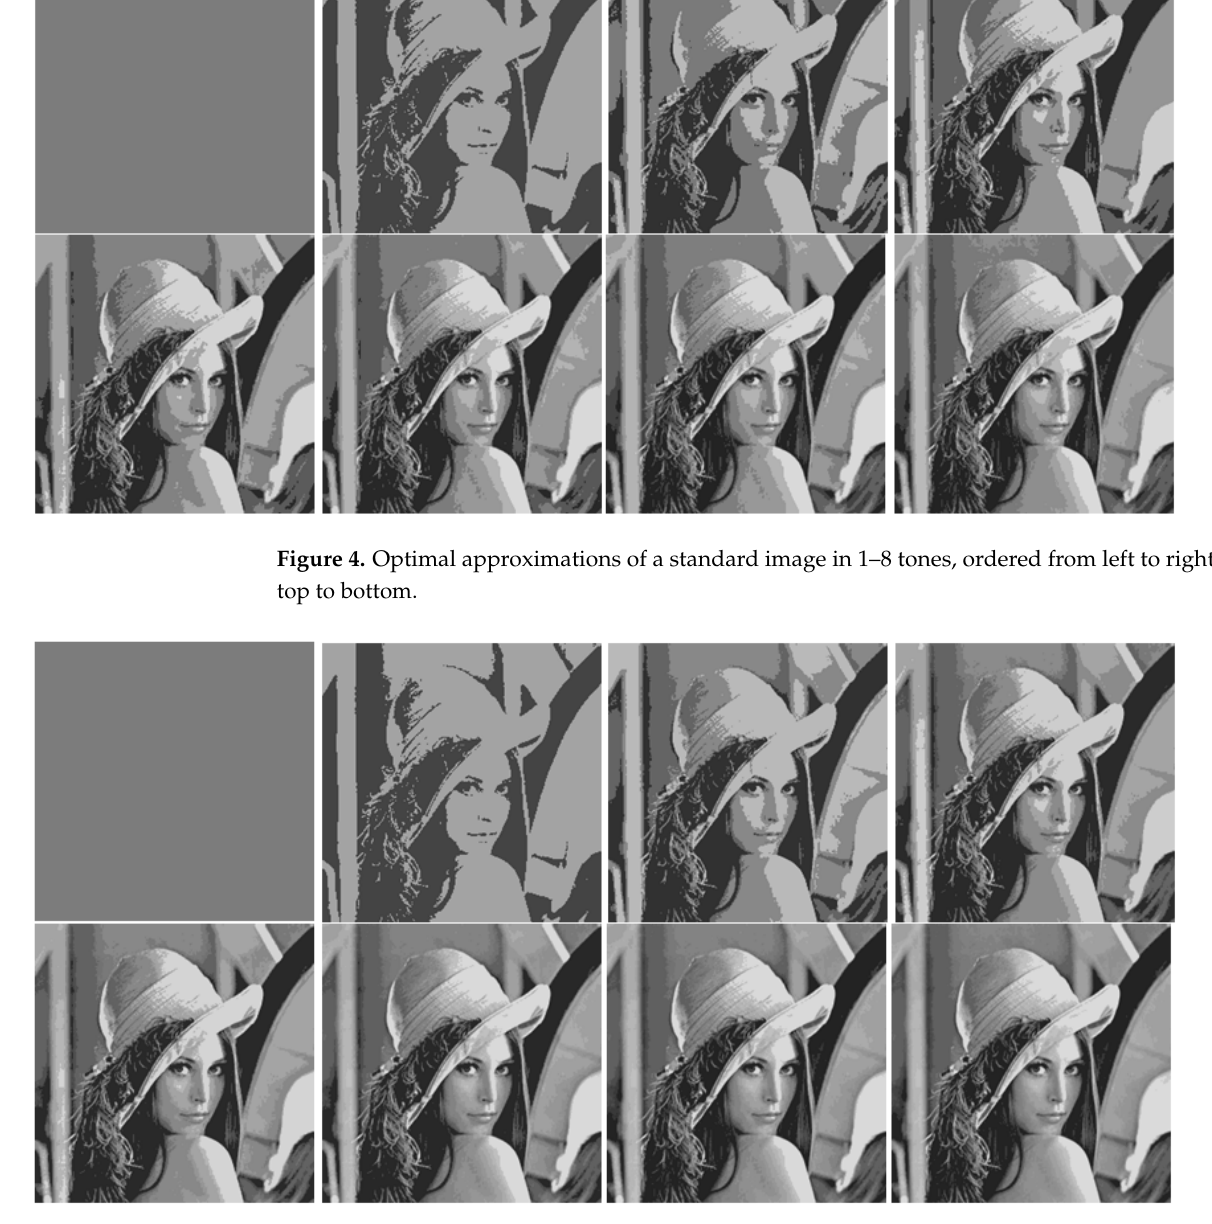
Figure 5. Hierarchy of superpixels generated by eight optimal approximations, ordered from left to right and top to bottom.